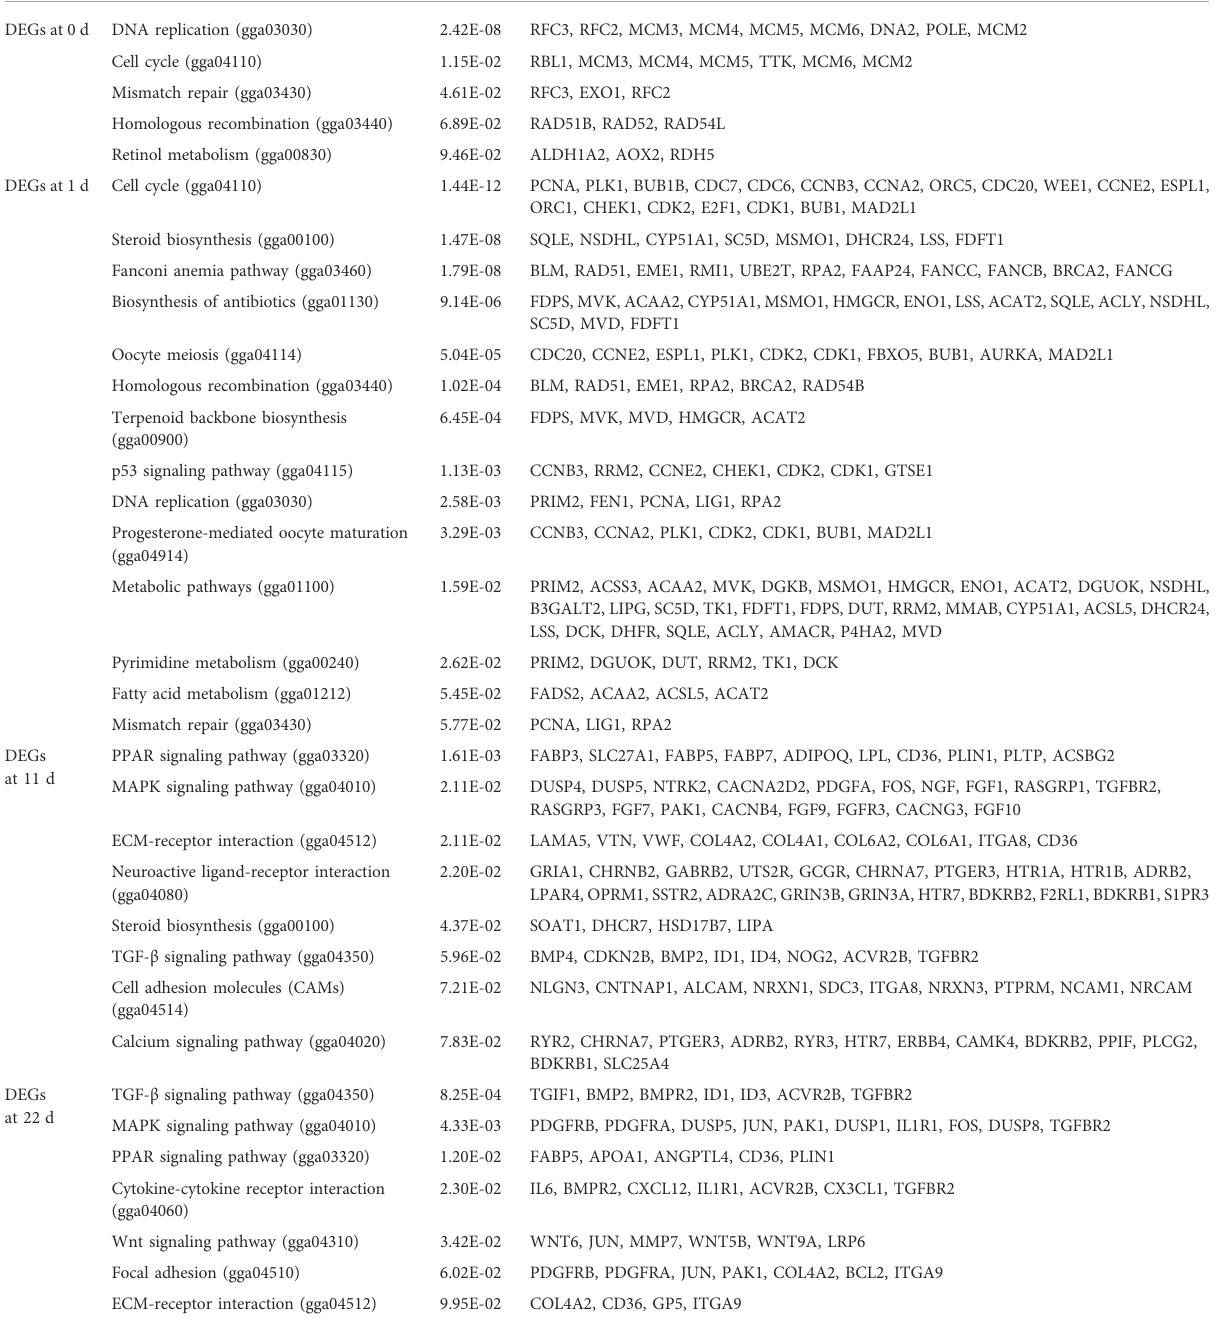
TABLE 2 KEGG pathway analysis of genes at the different induction times and corresponding modules.